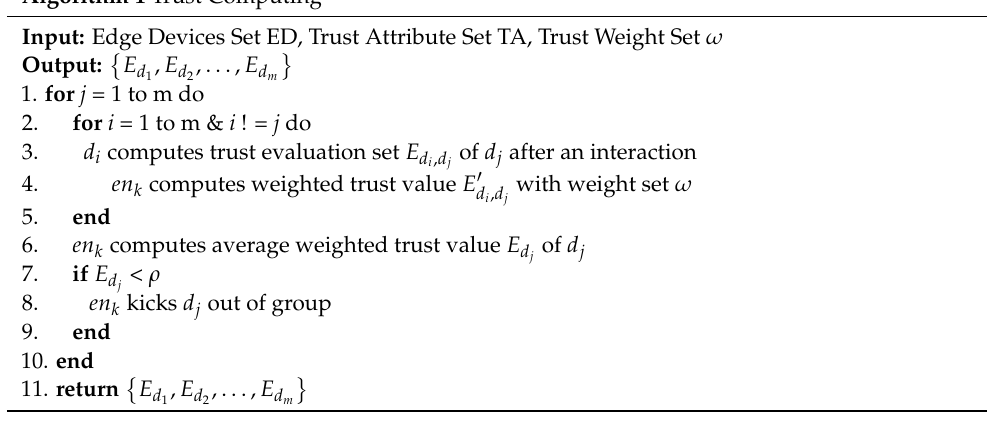
Algorithm 2 Moore Curve List Construction